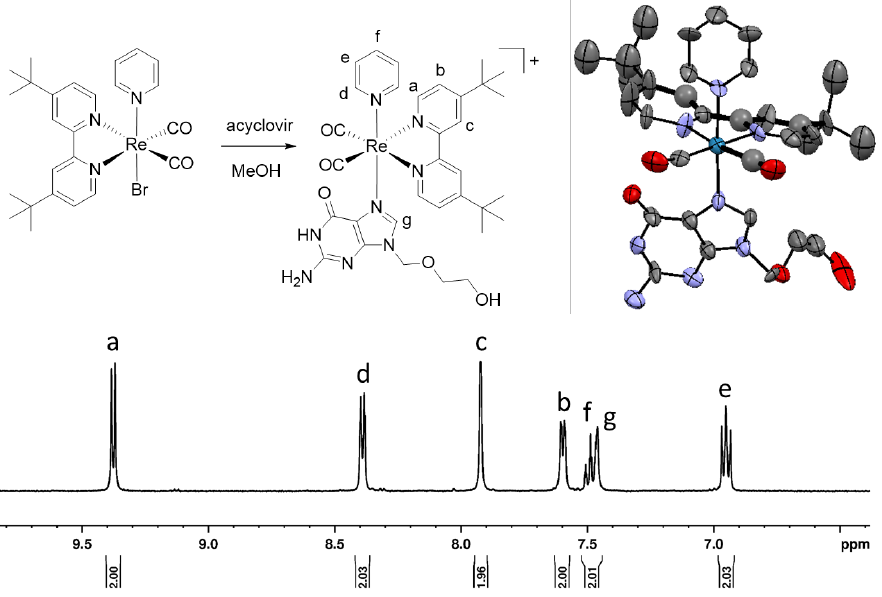
Figure 5. Aromatic region of NMR spectrum (in CD 2 Cl 2 ) of 15 cation and its structure, based on XRD data. Letters in the NMR spectrum refer to hydrogen resonance signals of 15 cation as of scheme.